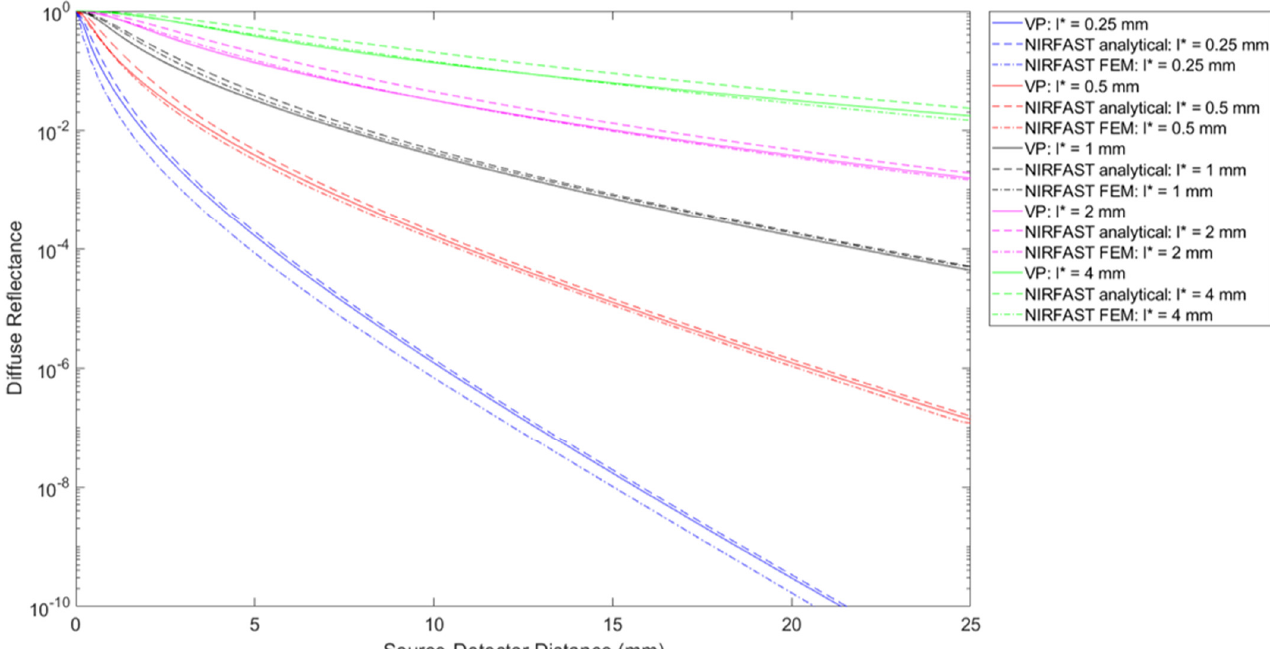
Figure 2. Diffuse reflectance versus source-detector separation distance for varying l* values, comparing the pre-validated virtual photonics (VP) solution and NIRFAST analytical solution, to the NIRFAST FEM-based SRS models. These reflectance plots are normalized to the zero source-detector distance.